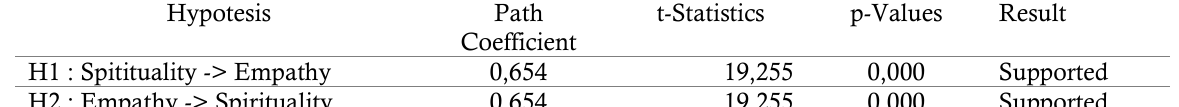
Table 4. Hypotesis Testing